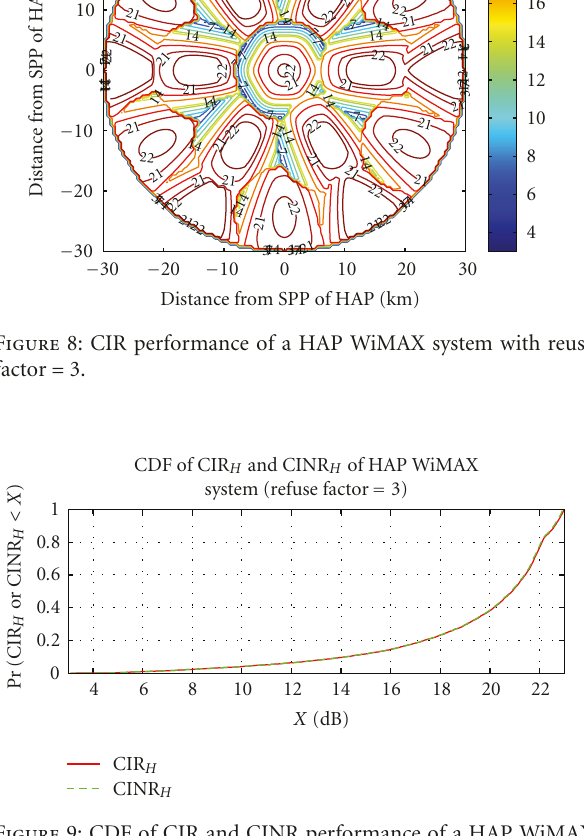
Figure 9: CDF of CIR and CINR performance of a HAP WiMAX system with reuse factor = 3.